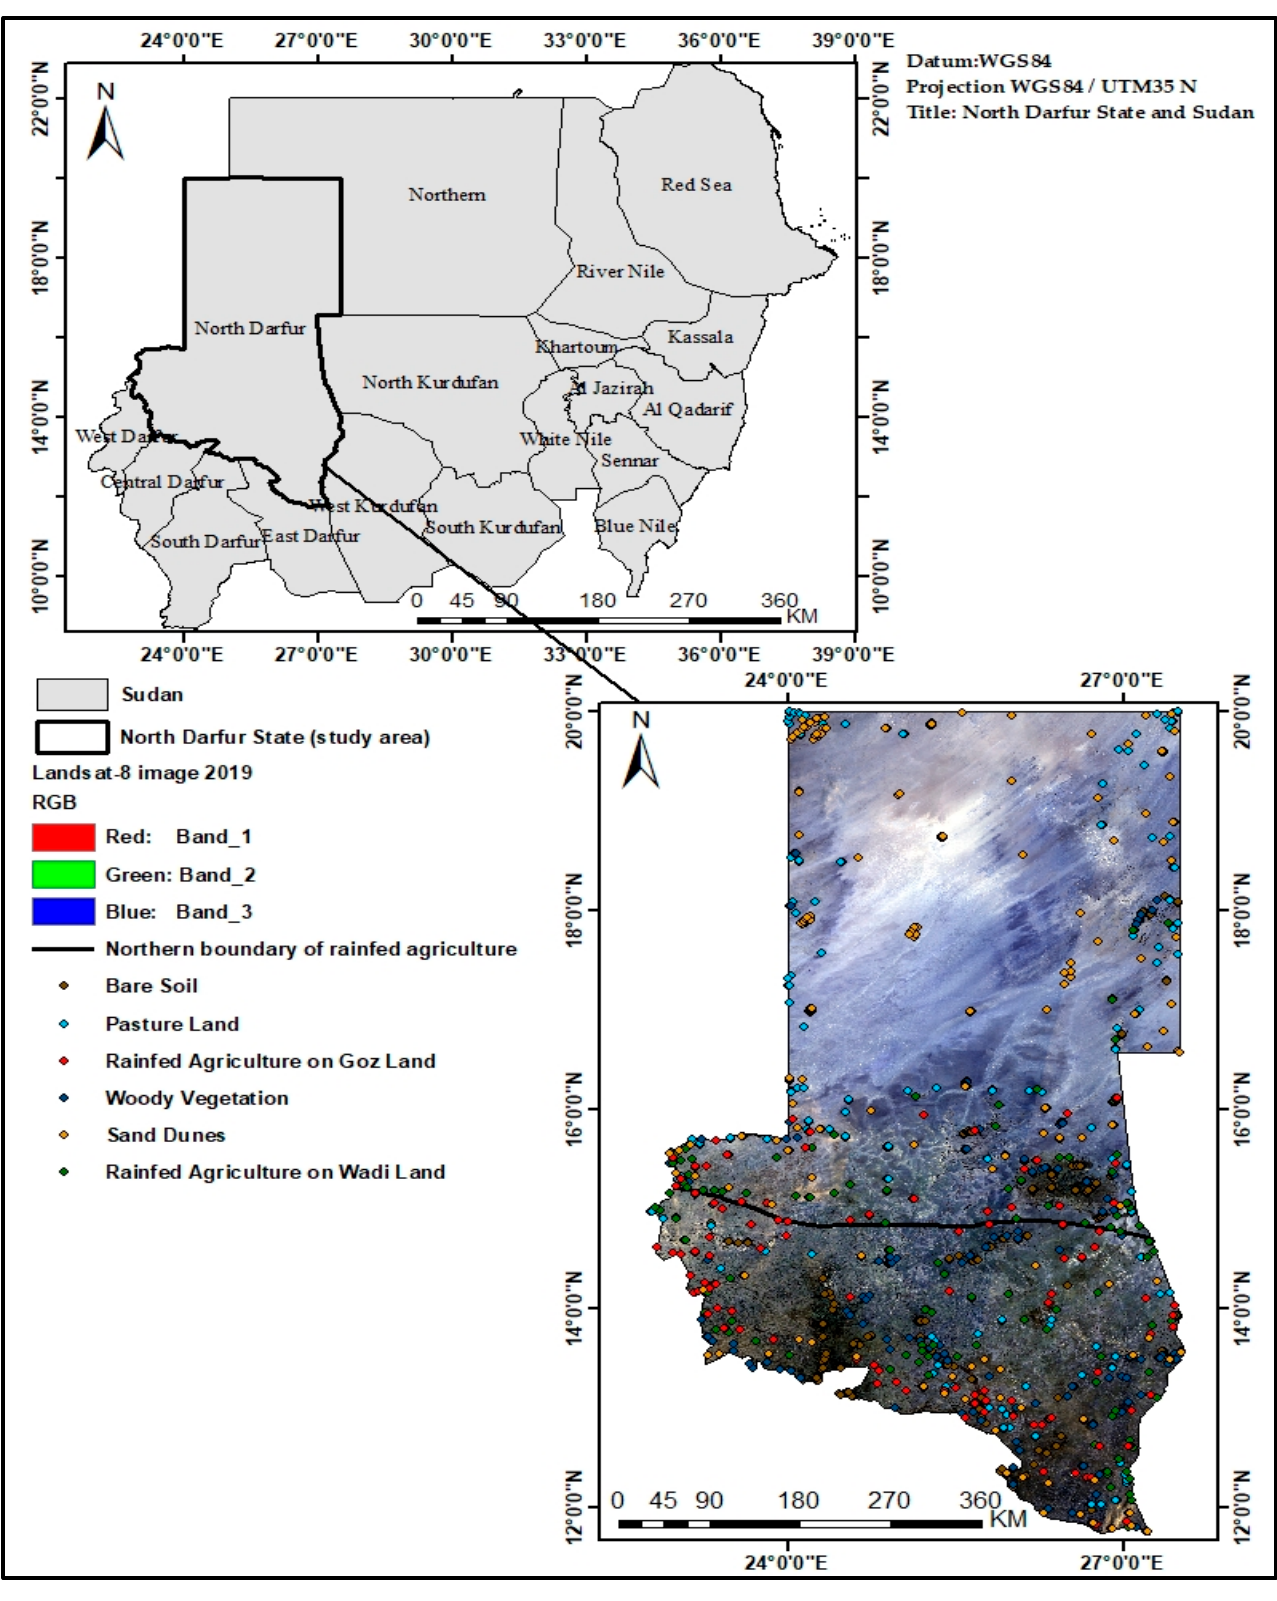
Figure 1. Location of the study area with spatial distribution of the samples in Landsat-8 image 2019. The northern boundary for rainfed agriculture was identified in 1984 using field observation.